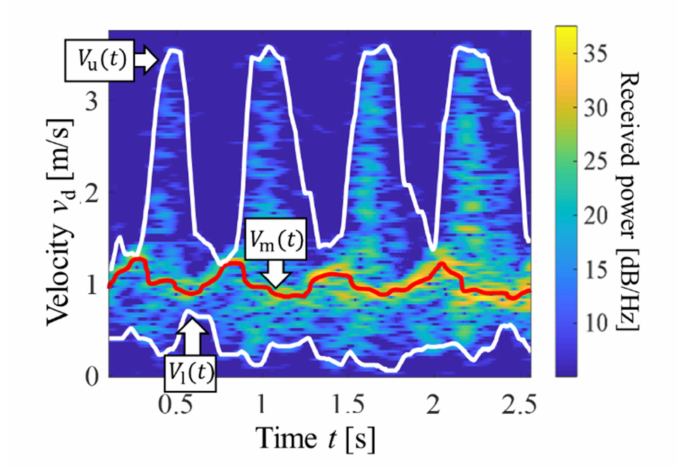
Figure 2. Representative spectrogram of experimental MDR data for gait measurement. v d is the Doppler velocity calculated using the Doppler